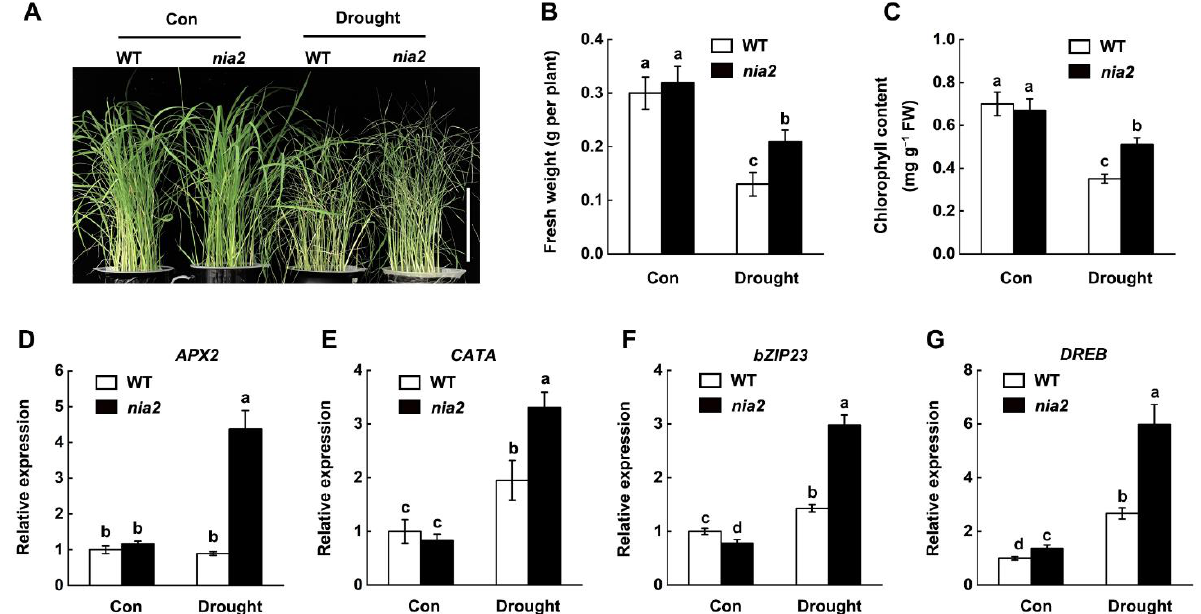
Figure 8. Knockdown of NIA2 enhances rice drought tolerance. ( A ) Photographs of 14-day-old well-irrigated wild-type (cv. Dongjin, WT) and nia2 mutant rice seedlings were withdrawn from irrigation for 6 days. Scale bar = 10 cm. ( B,C ) The related fresh weight and chlorophyll content were determined. ( D – G ) Relative transcript levels of genes involved in drought stress response in rice seedling leaves were quantified after 4 days of drought stress by qRT-PCR. Expression levels are relative to corresponding untreated wild-type samples (control) after normalization to OsActin1 and OsActin2 . Data are means ±SD ( n = 3). Lower case letters indicate significant differences at p < 0.05 (Duncan’s multiple range t ests).